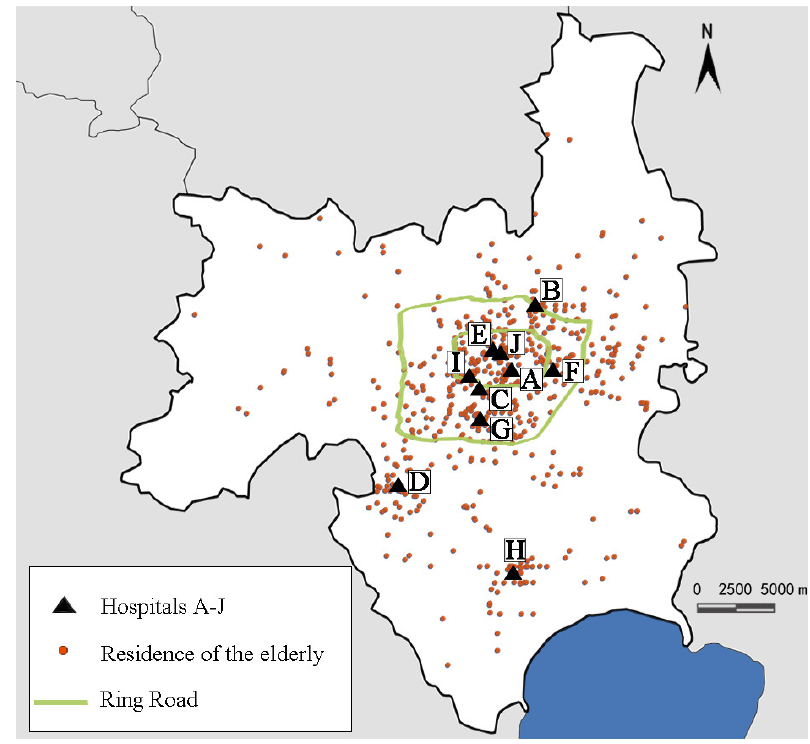
Figure 2. Location of hospitals and residences of the elderly in the survey.